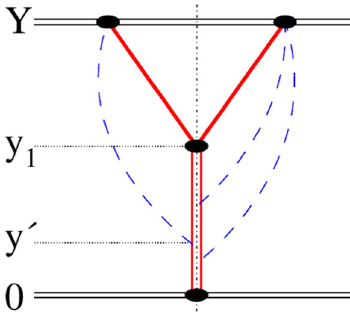
Fig. 5 Semi-enhanced diagrams (shown by the dashed blue lines) which describe the probability of LRG survival with respect to the inter- actions with the intermediate